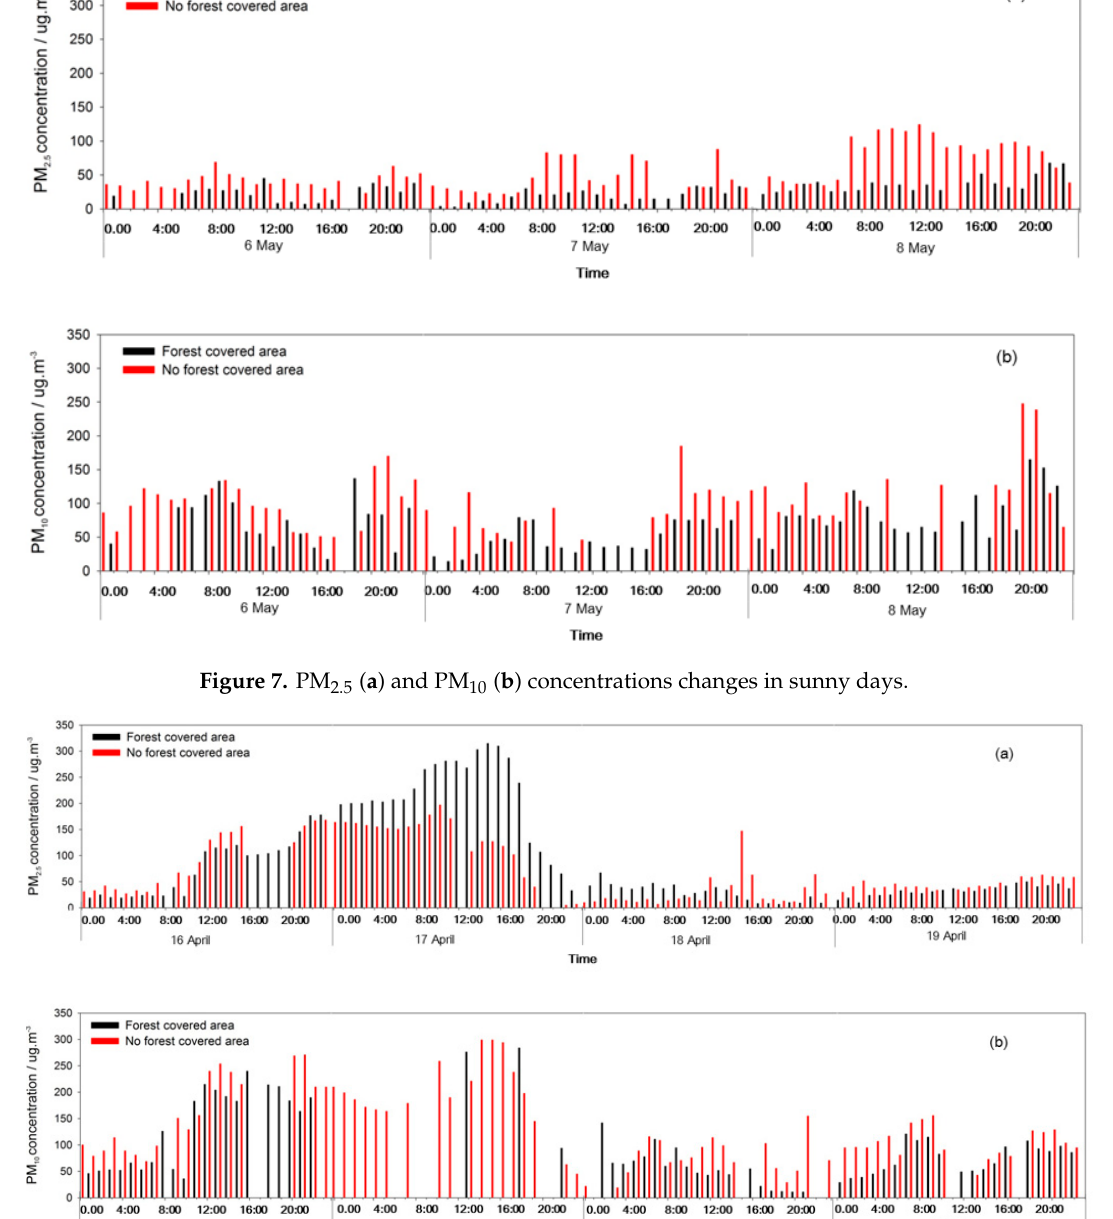
Figure 9. PM 2.5 ( a ) and PM 10 ( b ) concentrations changes in heavy pollution event. The overall reduction efficiency for PM 2.5 was higher than for PM 10 , except for during a heavy pollution event. It can be seen that forests have a prominent effect on the reduction of fine particles, such as PM 2.5 . The reduction efficiency results for PM 10 under the different weather conditions showed that forests were most efficient on sunny days, followed by the light pollution event, then the heavy pollution event, and the dust storm period was the least efficient one; however, for PM 2.5 , the reduction efficiency of the heavy pollution event was the least (Figure 10a).